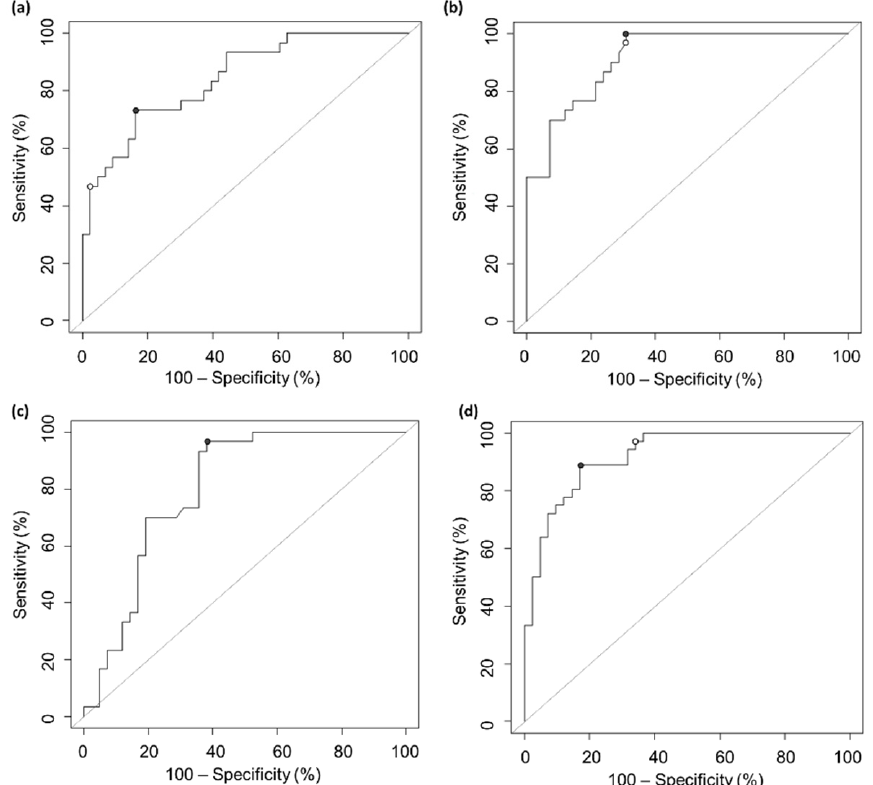
Figure 3. ROC curves relevant to ( a ) Roche Elecsys ® Anti Spike test, ( b ) Snibe MAGLUMI ® S-RBD IgG test, ( c ) Snibe MAGLUMI ® S/N IgG test and ( d ) EUROIMMUN ® NeutraLISA test. The black points indicate Youden’s index-optimized cut-off, and the white points indicate the odds-ratio optimized cut-off. Table 4. Optimized parameters from the ROC curves, calculated by the Youden’s index, relevant to each serological assay.